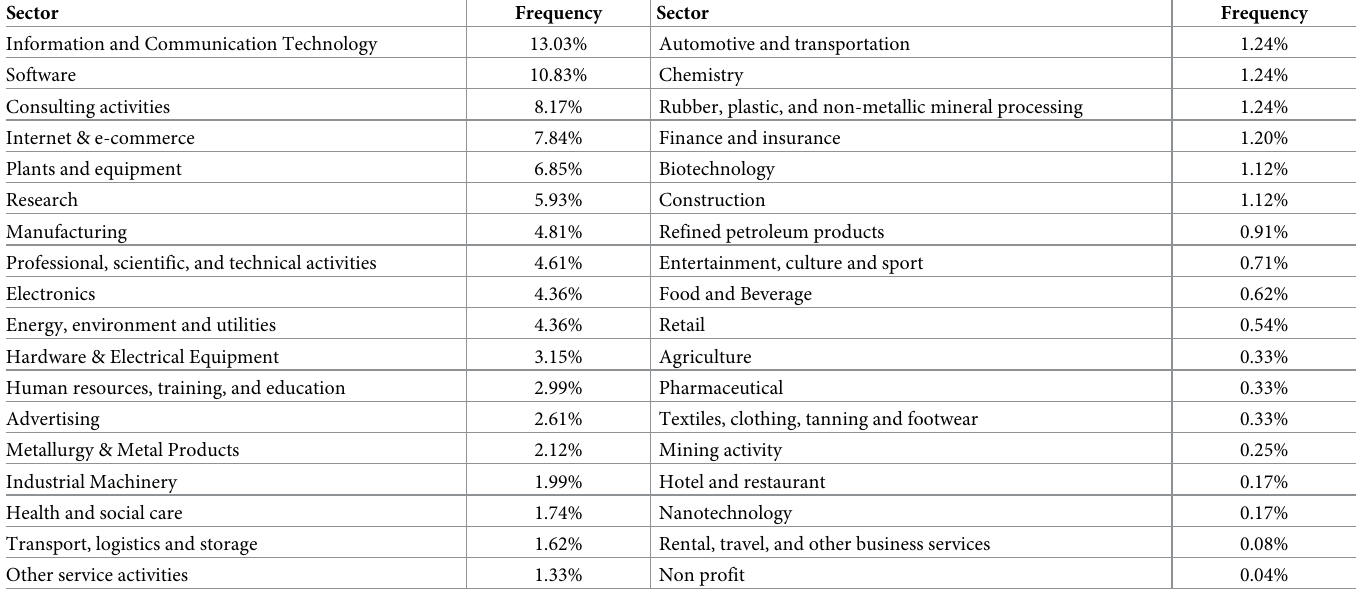
Table 2. List of sectors and relative